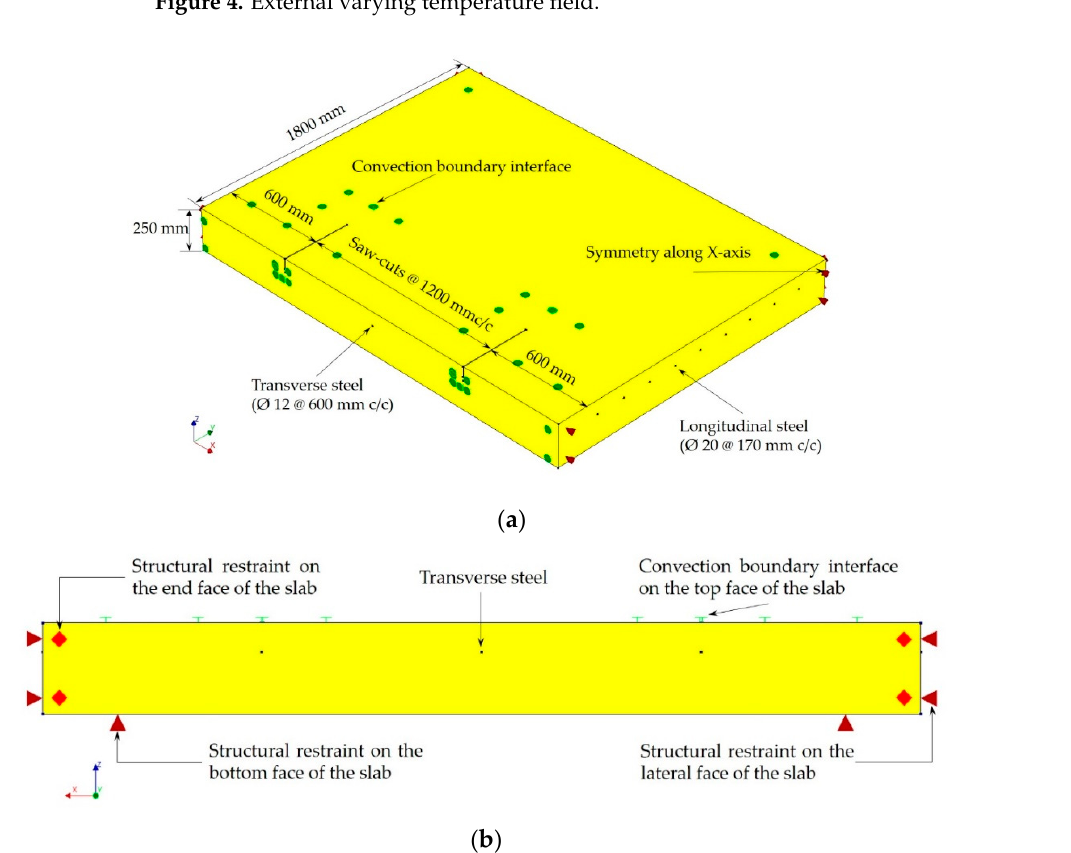
Figure 5. Boundary conditions of the 3D FE model: ( a ) Thermal boundary conditions; ( b ) Structural boundary conditions.